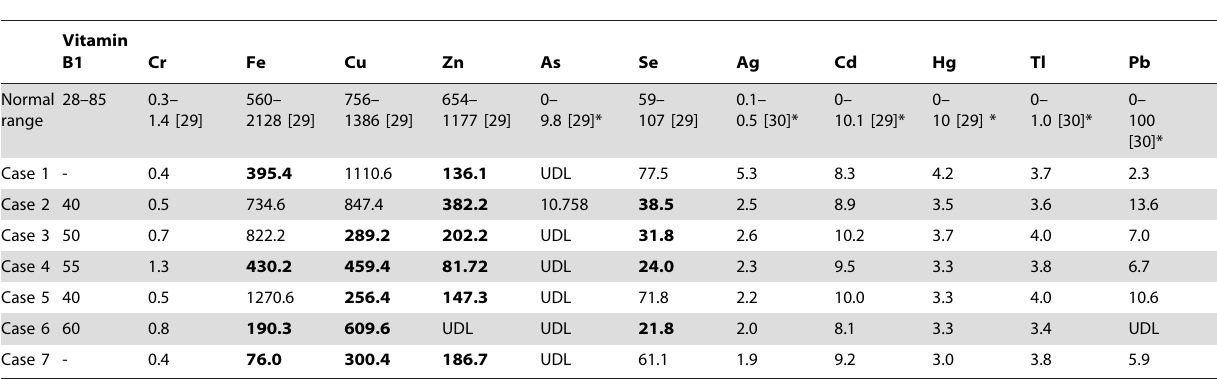
Table 4. Serum analysis ( m g/L) of peripheral neuropathy cases, Papua New Guinea, 2010.